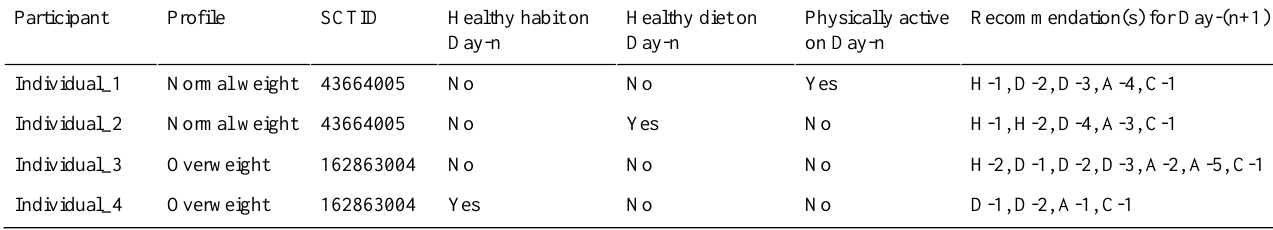
Table 1. Recommendation generation for participants for Day-(n+1)